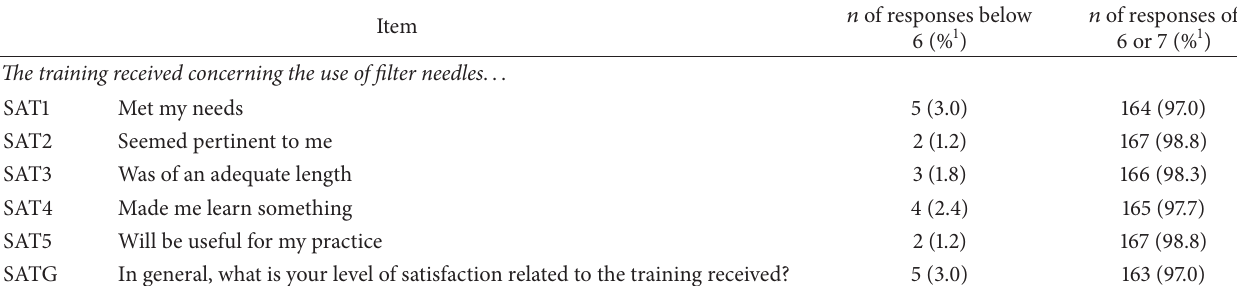
Table 4: Nurse satisfaction with the